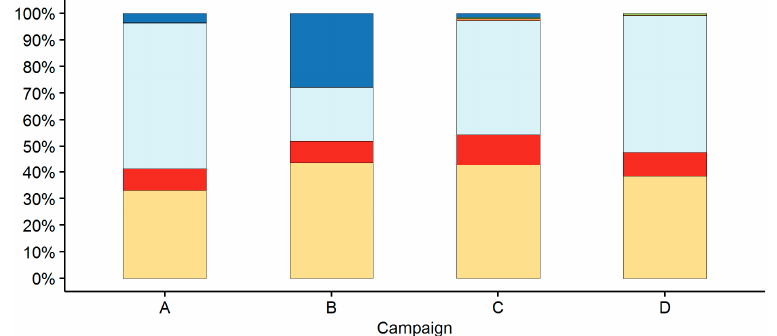
Figure 3. Share of productive time (PSH 0 ) ( beige ) and the various delay times: IT (interference time) ( red ); PT (preparatory times) ( light blue ); MT (maintenance times) ( orange ); RP (rest and personal times) ( green ); and RT (repair times) ( navy ), as measured during shift level (SSH Total ) on the operation site including pre-operational processes such as rigging but excluding official break and meal times.